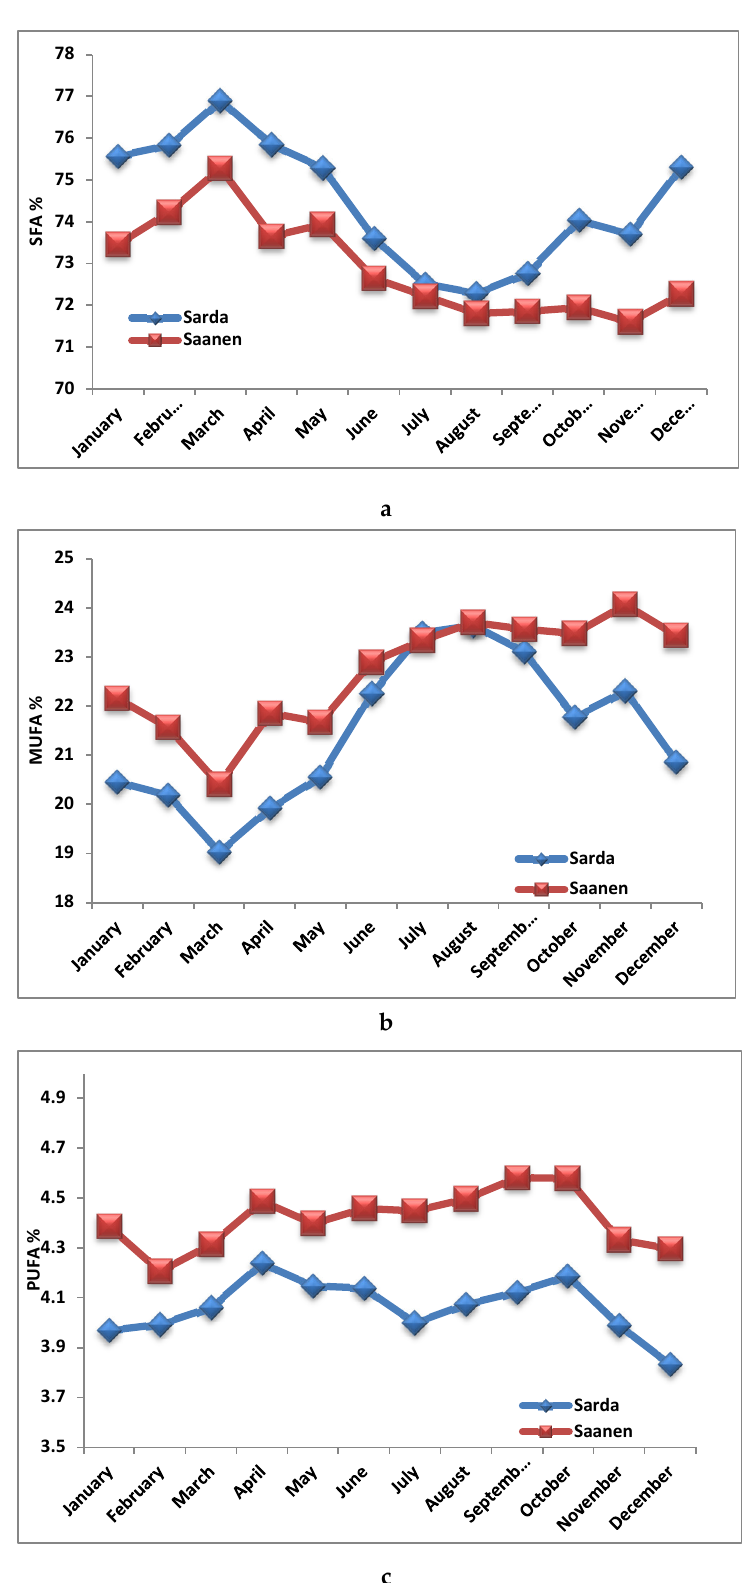
Figure 4. Monthly calculated mean % contents of: ( a ) saturated fatty acids (SFA); ( b ) unsaturated fatty acids (MUFA); ( c ) polyunsaturated fatty acids (PUFA). Data are reported for the Sarda (blue line and diamonds) and Saanen (red line and squares) groups of milk samples.